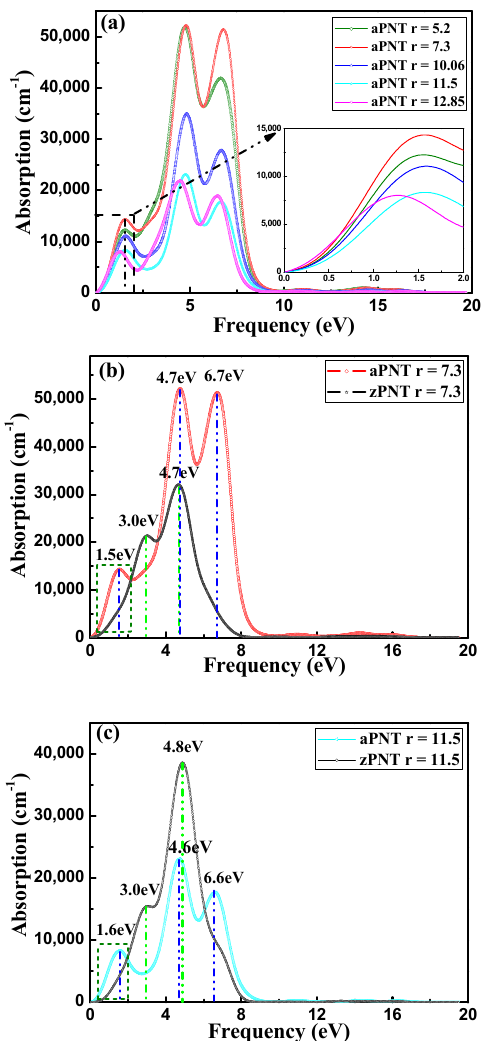
Figure 10. Absorption coefficient of BP nanotubes with electric field direction parallel to the radius. ( a ) aPNTs with different radii; ( b ) aPNT and zPNT with a radius of 7.3 Å, and ( c ) aPNT and zPNT with a radius of 11.5 Å.